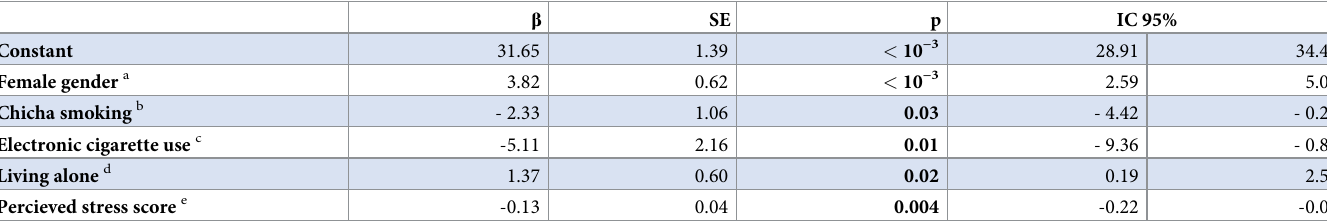
Table 4. Associated factors with adherence to preventive behaviors related to COVID-19 among medical students (Multiple regression analysis).